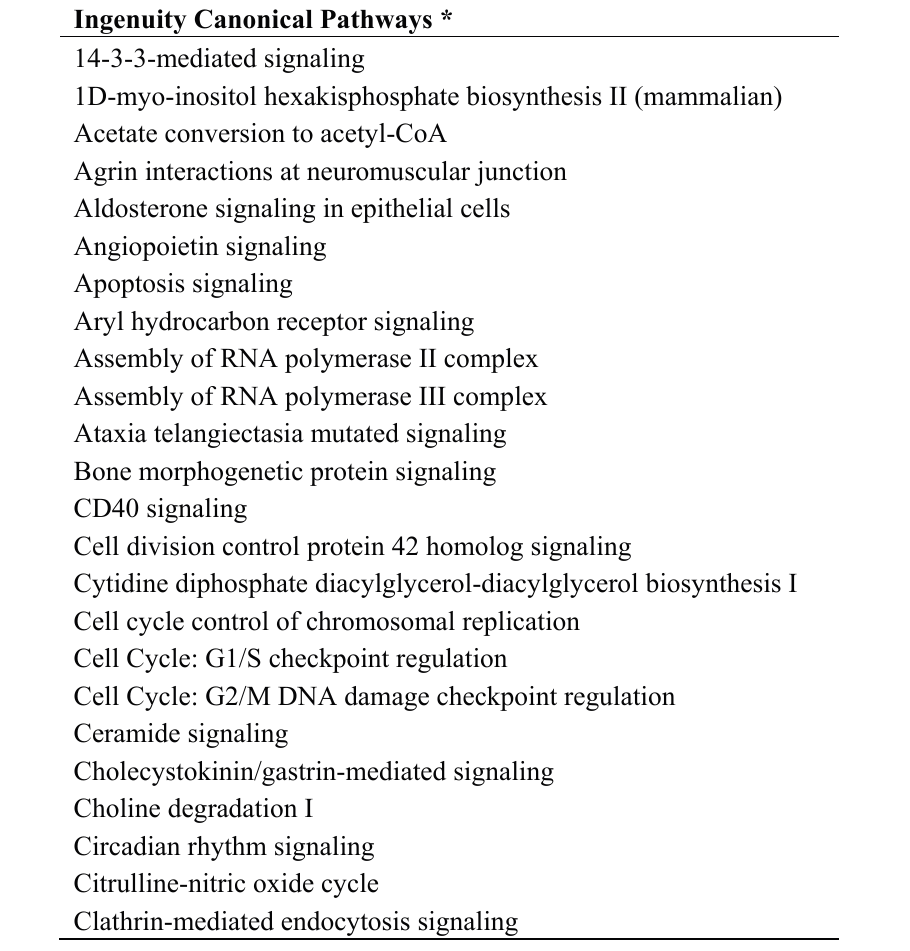
Table 4. Common cell growth and developmental pathways in both MBD5 and RAI1 knockdown SH-SY5Y